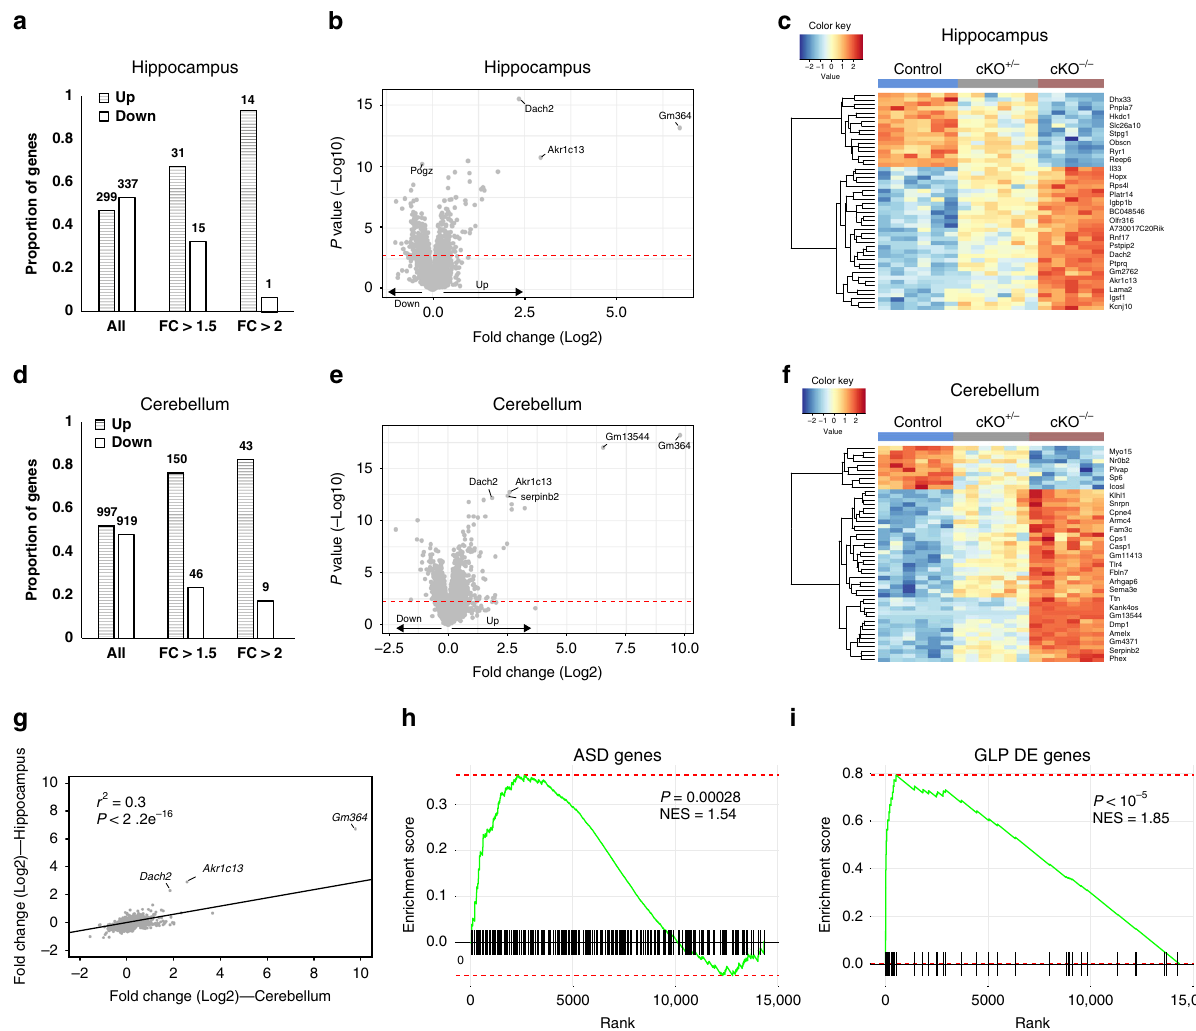
Fig. 5 Pogz de fi ciency leads to transcriptional dysregulation. a , d Proportion of up- and downregulated genes in the a hippocampus or d cerebellum of Pogz -de fi cient mice. Bars correspond to all genes (left), genes with fold change > 1.5 (middle) and genes with fold change > 2 (right). b , e Volcano plot showing differentially expressed genes in the b hippocampus or e cerebellum. P values were calculated by edgeR. The red line indicates FDR = 0.05. Up and down (bottom left) indicate genes upregulated and downregulated (respectively) in the Pogz -de fi cient mice. c , f Heatmap of the 50 most signi fi cant genes in the c hippocampus or f cerebellum. The color corresponds to the scaled expression levels (blue — negative, red — positive). g Correlation between fold changes of gene expression in the hippocampus and the cerebellum. The correlation, signi fi cance and linear regression were calculated using an iteratively re-weighted least squares algorithm (lmrob function in the ‘ Robustbase Package ’ in R). h , i GSEA enrichment plots of genes differentially expressed in the hippocampus of Pogz -de fi cient mice (see also Supplementary Table S3). The signi fi cance of the enrichment was calculated using fgseaMultilevel function in the ‘ fgsea Package ’ in R. h ASD candidate genes (SFARI gene base, score 1 − 3) are enriched in gene upregulated in the hippocampus. i Genes differentially expressed in the GLP mouse model are signi fi cantly enriched among genes differentially expressed in the Pogz mouse